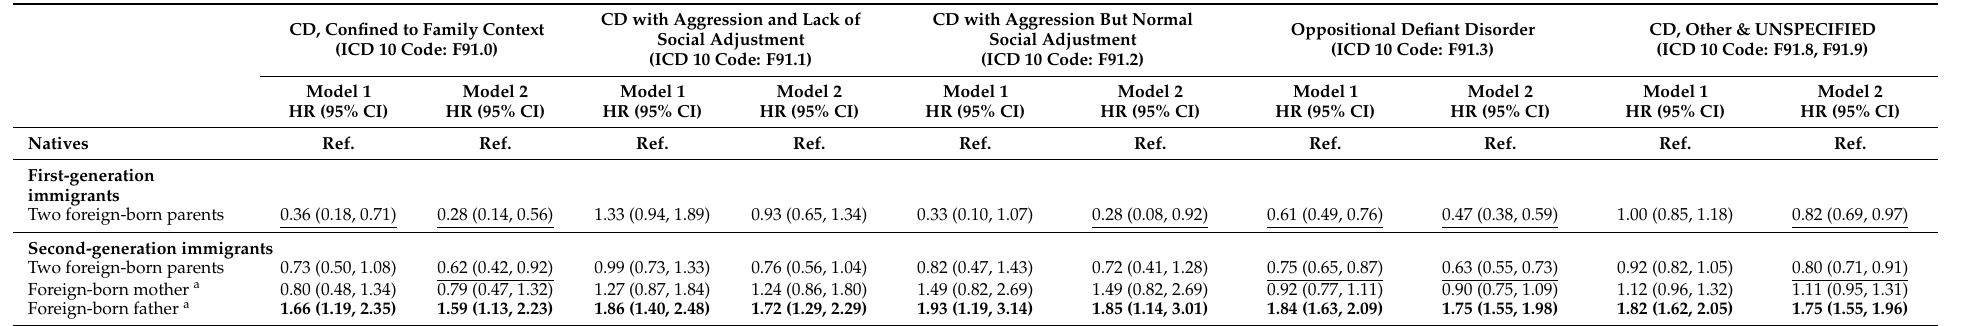
Table A2. Hazard Ratios of subtypes of conduct disorder in male participants with an immigrant background and 4–16 years at baseline compared with natives in Sweden, 2001–2015. CD with Aggression and Lack of CD, Confined to Family Context Social Adjustment (ICD 10 Code: F91.0) (ICD 10 Code: